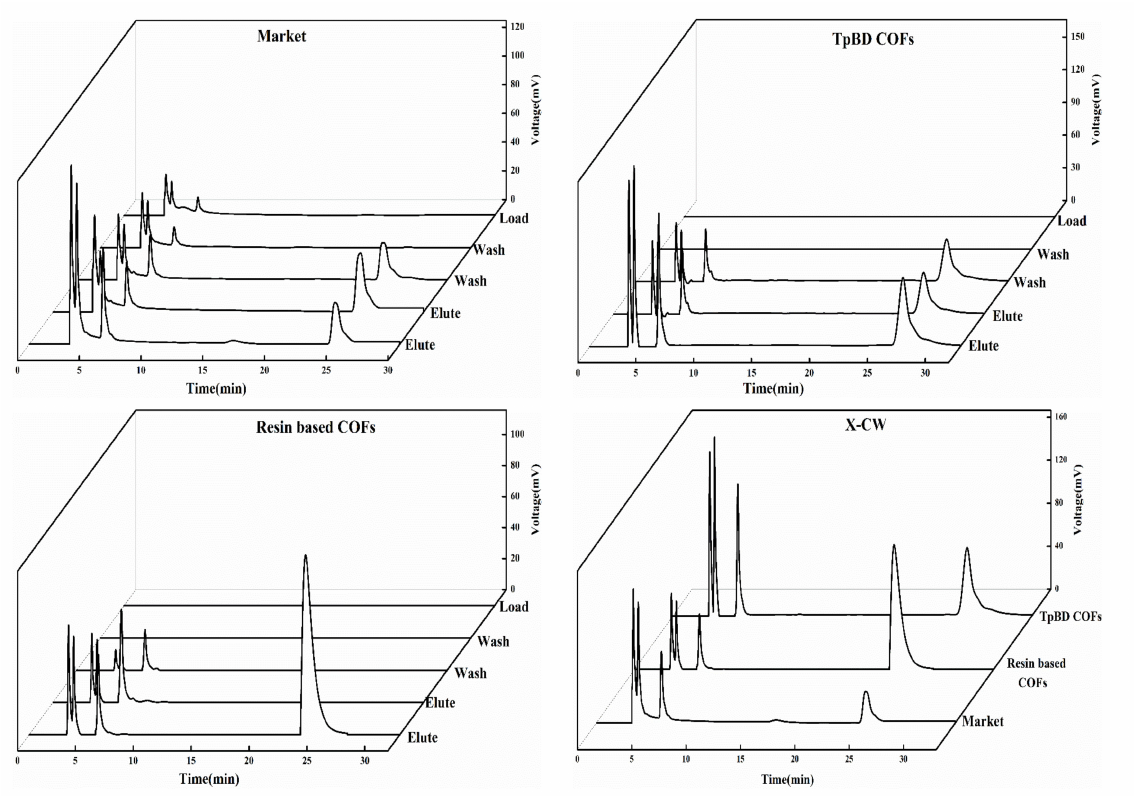
Figure 6. Outflow curves using the X-CW method.